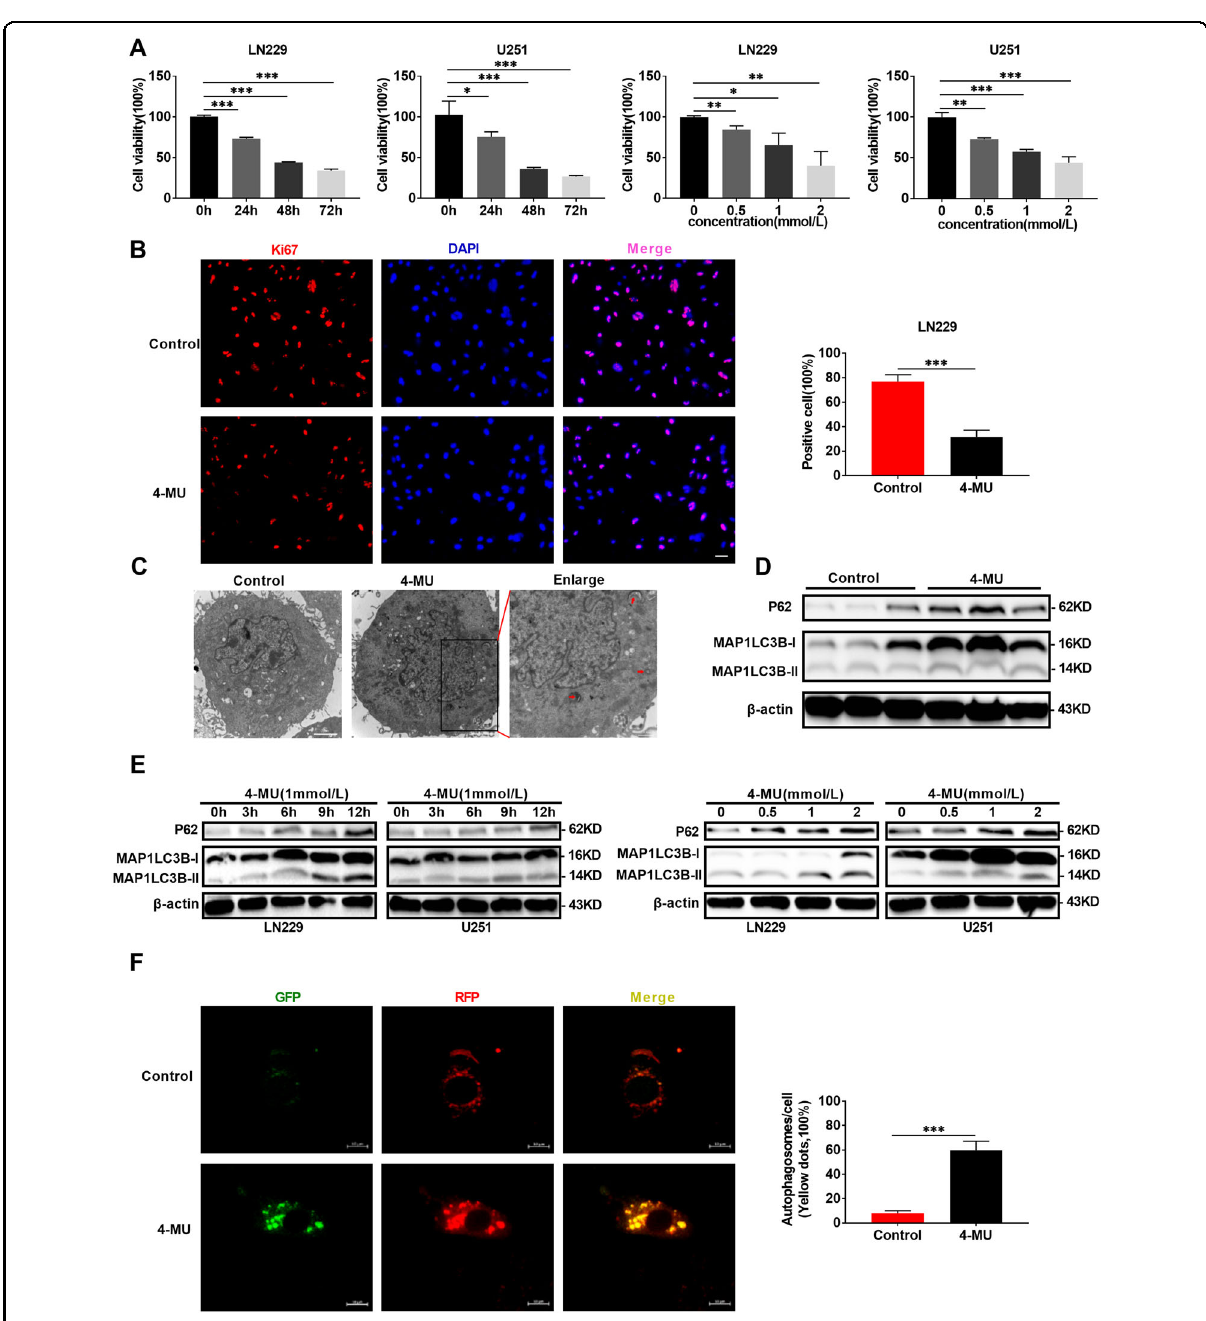
Fig. 6 4-MU decreases glioma viability and blocks autophagy fl ux. A Viability of U251 and LN229 glioma cells treated with 4-MU (1 mmol/L) for 0, 24, 48, and 72 h. Viability of U251 and LN229 glioma cells treated with different concentrations of 4-MU (0, 0.5, 1, or 2 mmol/L) for 48 h. B Levels of the Ki67 protein in LN229 glioma cells were detected using immuno fl uorescence staining after treatment with 4-MU for 48 h. Scale bar: 50 μ m. C TEM images of U251 glioma cells treated with 4-MU for 48 h. The scale bars represent 2 µm in the original image and 0.8 μ m in the enlarged image. D Relative levels of the P62 and MAP1LC3B proteins in the orthotopic xenograft tumors from the control and 4-MU-treatment groups. E Relative levels of the P62 and MAP1LC3B proteins in U251 and LN229 glioma cell lines treated with 4-MU (1 mmol/L) for 0, 3, 6, 9, and 12 h. Relative levels of the P62 and MAP1LC3B proteins in U251 and LN229 glioma cell lines treated with different concentrations of 4-MU (0, 0.5, 1, or 2 mmol/L) for 48 h. F GFP-RFP- LC3 fl uorescence assays of U251 glioma cells treated with 4-MU for 48 h. Scale bar: 10 μ m. The data are presented as the mean ± SD; * P < 0.05, ** P < 0.01, and *** P < 0.001, **** P <